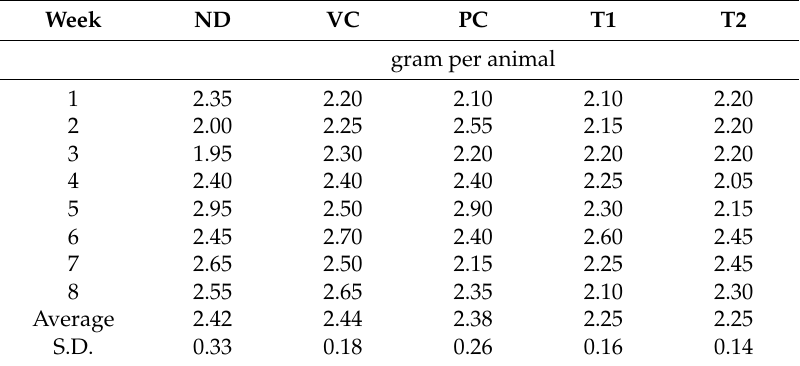
Table 1. The average food consumption per animal in each treatment group during pair feeding. The amount of food consumption was not significantly different between the groups.